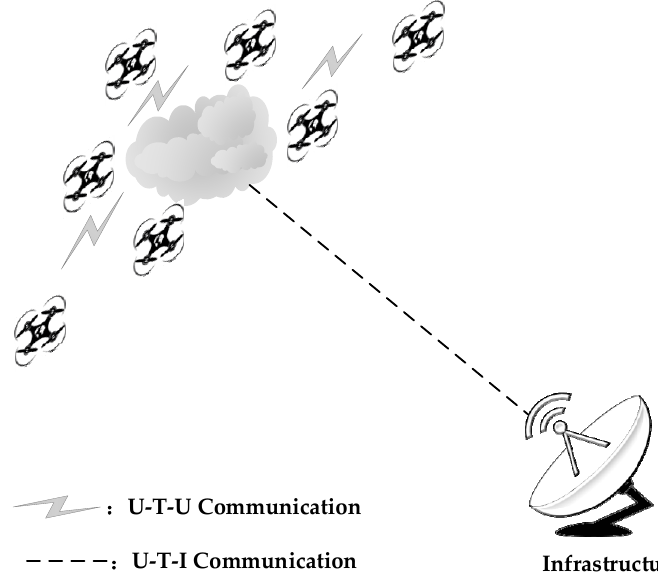
Figure 2. Schematic showing a single-group swarm Ad hoc network.